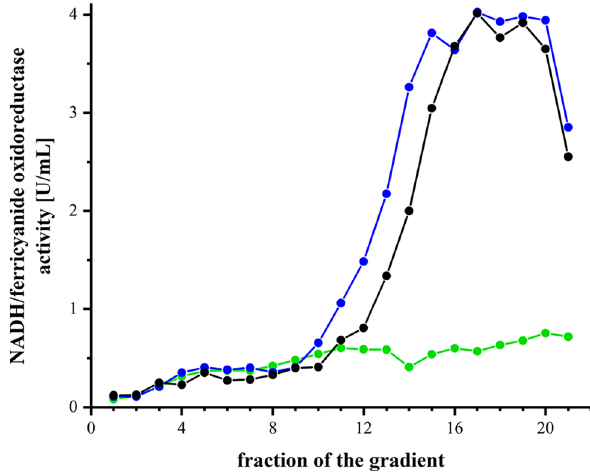
Figure 4. Sucrose gradient of detergent solubilized membranes from wild type (black) and the D213G H (blue) and V259A L (green) mutant strains. The NADH/ferricyanide oxidoreductase activity of each fraction is shown; the activities are normalized to 20 mg membrane protein extract applied on each